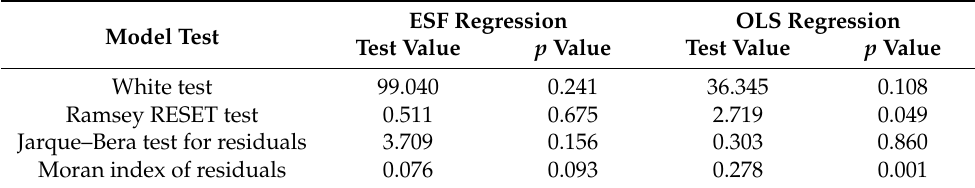
Table 6. Model test of OLS regression and ESF regression (ln(Comp_V) as dependent